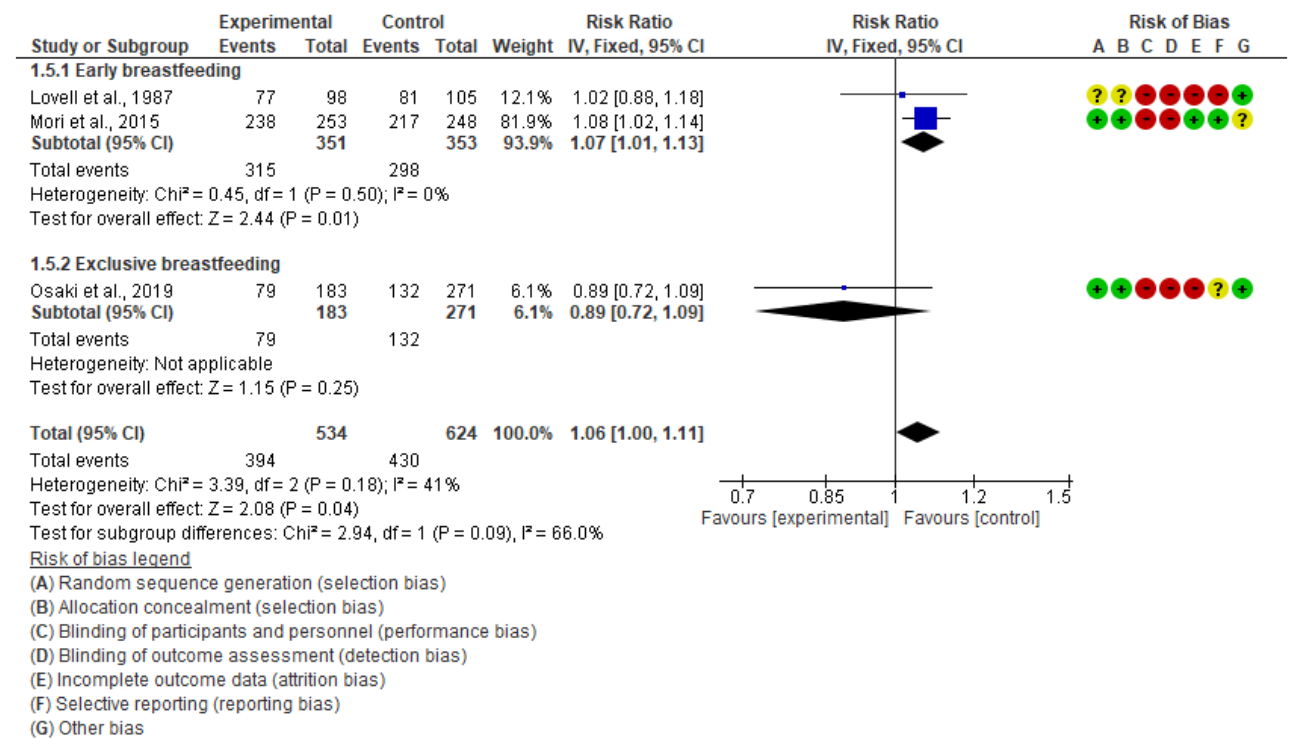
Figure 7. Meta-analysis for the effect of MCH handbook interventions vs. standard care on breast- feeding practice [19,20,22]. Red color with a − symbol means a high risk of bias, yellow color with a ? symbol means an unclear risk of bias, and green color with a + symbol means a low risk of bias.